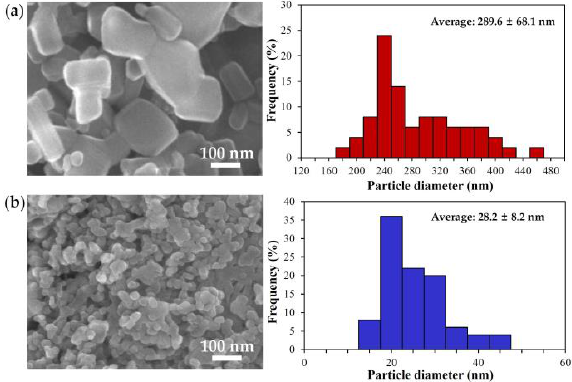
Figure 1. Scanning electron microscopic (SEM) images and size distribution of ( a ) bulk ZnO and ( b ) nano ZnO. Particle size distribution was determined by randomly selecting 200 particles from the SEM images.